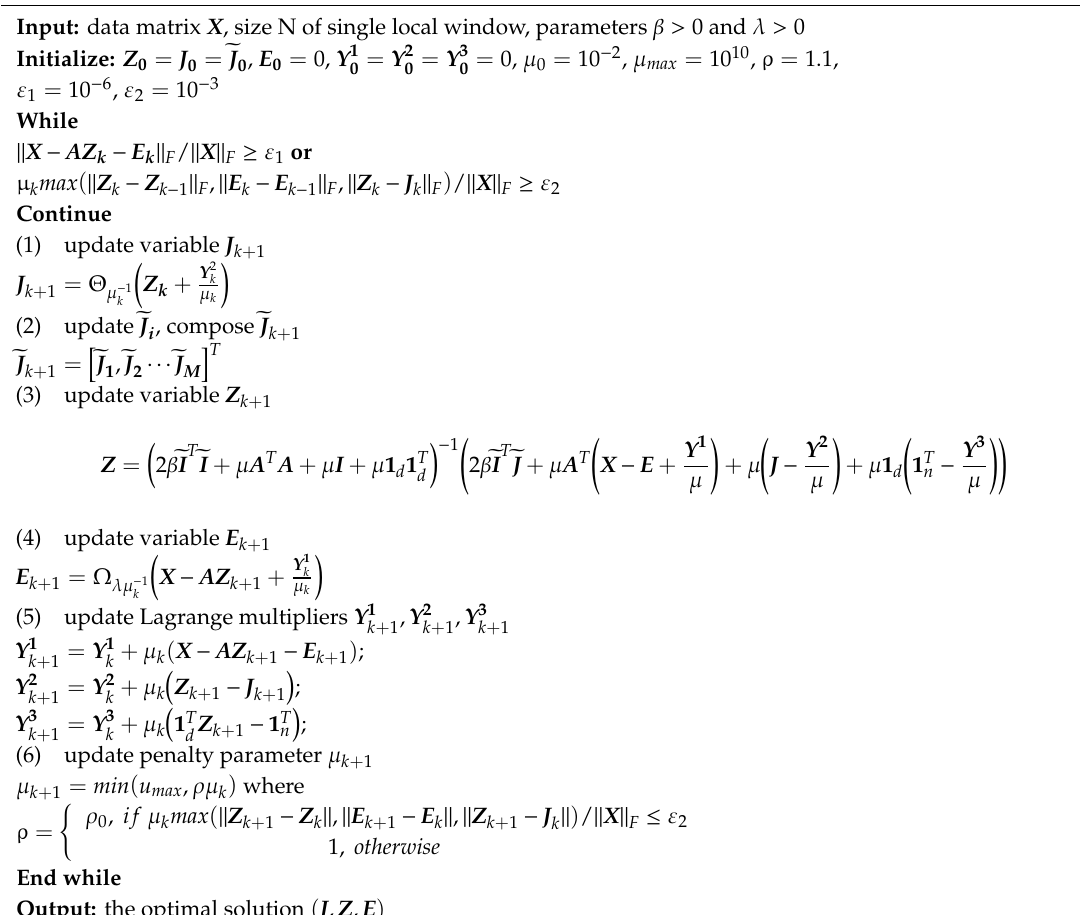
Algorithm 1. Inexact ALM algorithm for